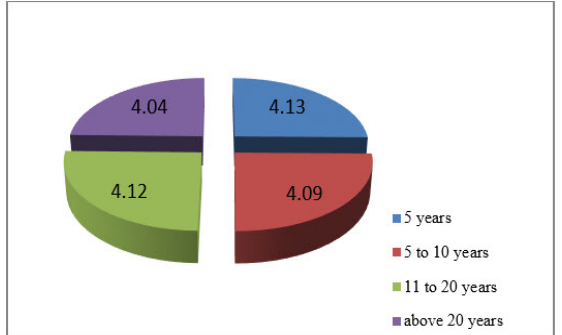
Graph 2. Graphic presentation of